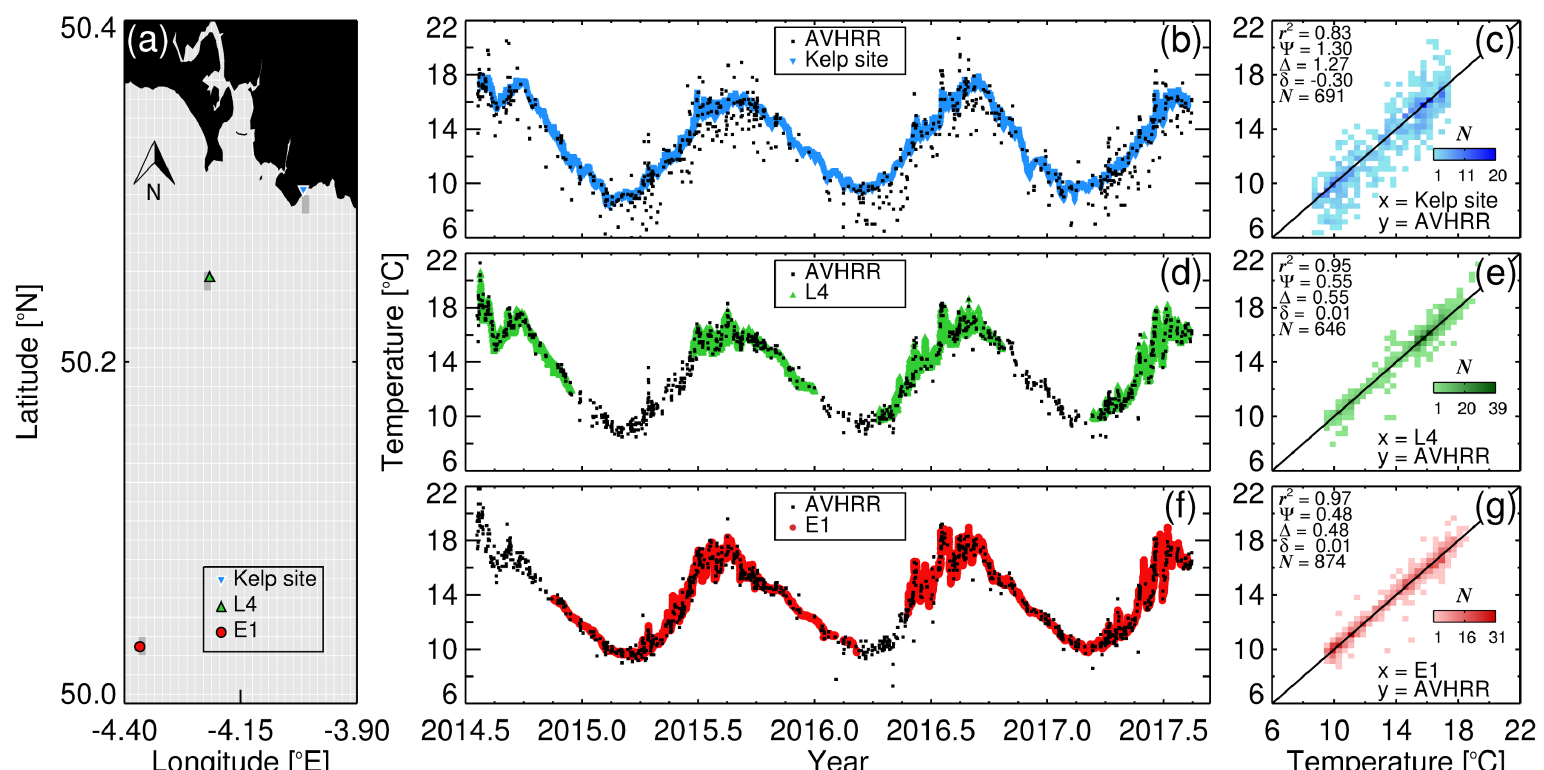
Figure 2. Comparison of Level 3 AVHRR SST N passes and in situ data near Plymouth, UK. ( a ) locations of in situ time-series data at the kelp site, at Station L4, at Station E1, and the closest pixels selected from the AVHRR mapped Level 3 passes to be representative of the three locations (dark grey pixels); ( b ) time-series of AVHRR SST N passes for the pixel closest to the kelp site overlain onto in situ temperature data from the kelp site; ( c ) scatter plots of match-ups (within ± 1h) between in situ temperature data from the kelp site and AVHRR SST N data at the kelp site; ( d ) time-series of AVHRR SST N passes for the pixel closest to L4 overlain onto in situ SST at L4; ( e ) scatter plots of match-ups (within ± 1h) between SST acquired in situ and by AVHRR at L4; ( f ) time-series of AVHRR SST N passes for the pixel closest to E1 overlain onto in situ SST at E1; ( g ) scatter plots of match-ups (within ± 1h) between SST acquired in situ and by AVHRR at E1. r 2 is the coefficient of determination, Ψ the root mean square error, δ the bias, ∆ the centre-pattern (or unbiased) root mean square error, and N the number of